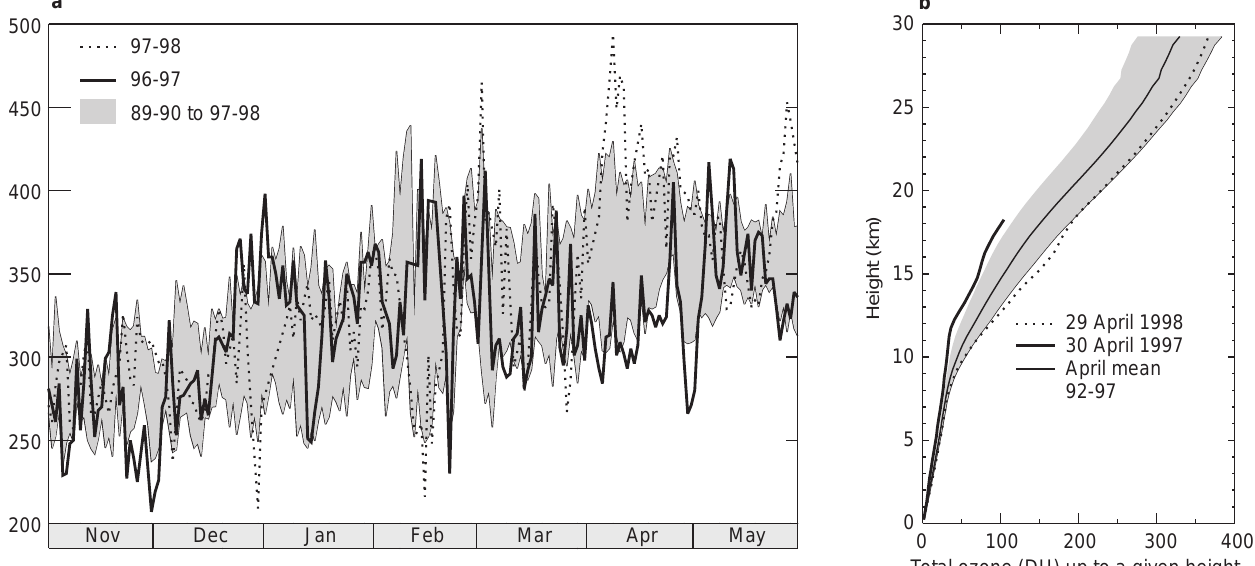
for 30 April 1997; thick broken line : observations for 29 April 1998; thin solid line : mean values for April observations; shaded region : mean (cid:6) 1 standard deviation. The mean and standard deviations were calculated from the 28 individual profiles measured in April between 1992 and 1997, but excluding the profile measured on 30